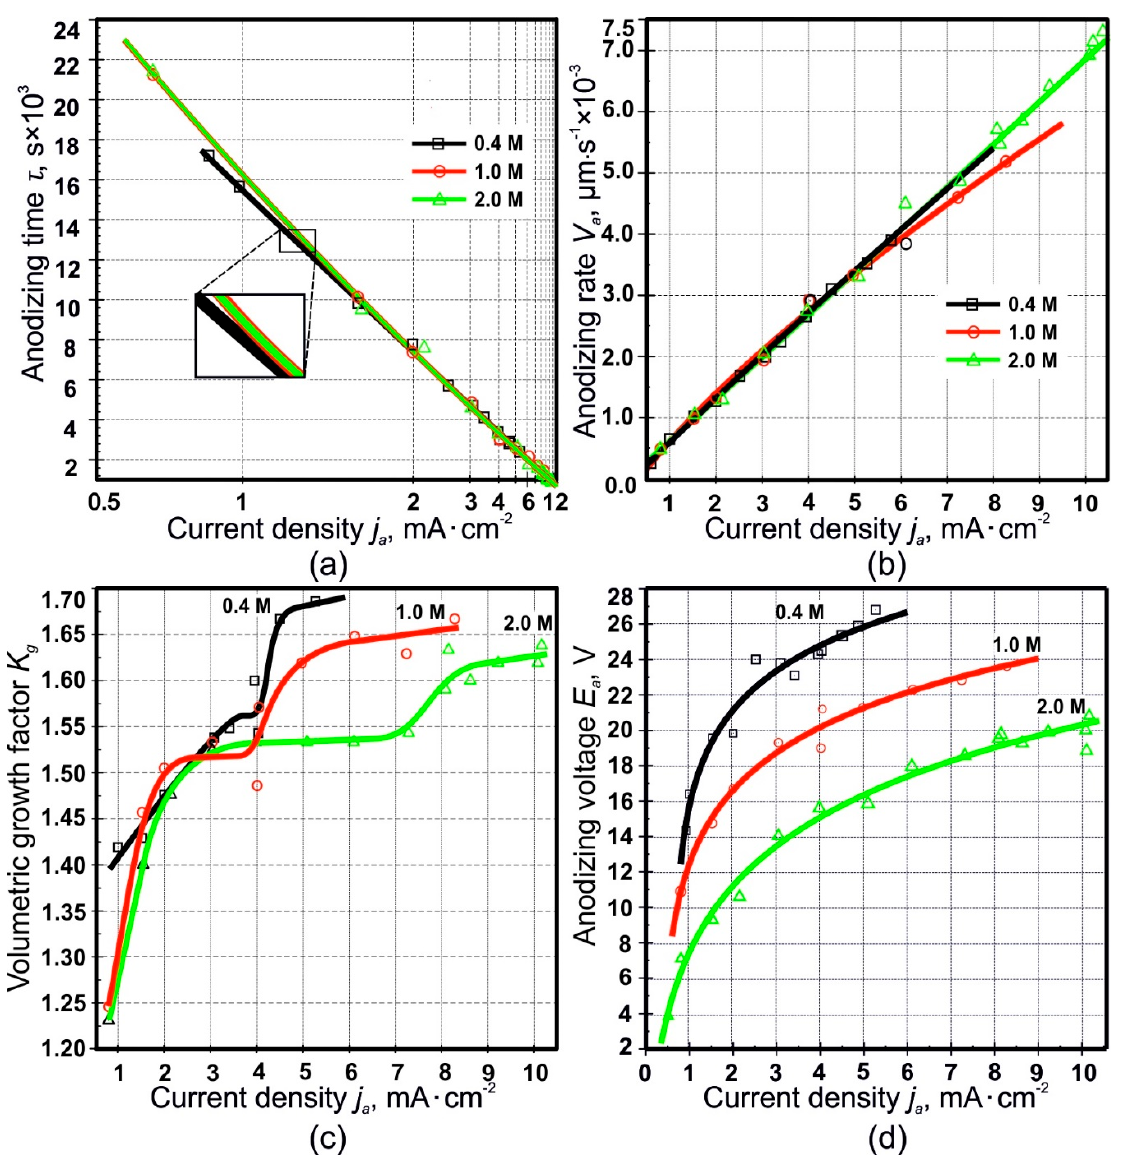
Figure 3. Dependence of the time τ of full anodizing ( a ), anodizing rate V a ( b ), volumetric growth factor K g ( c ), and anodic voltage of stationary region II E a ( d ) on current density j a of porous alumina films samples fabricated at current densities j a of 0.75–10 mA ∙ cm − 2 and sulfuric acid concentrations of 0.4–2.0 M.